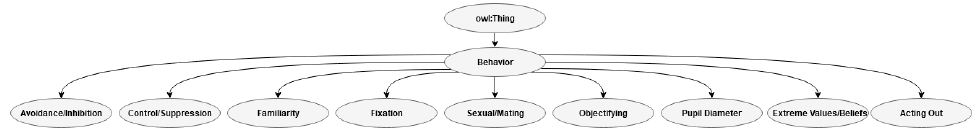
Figure 4. Class behavior.